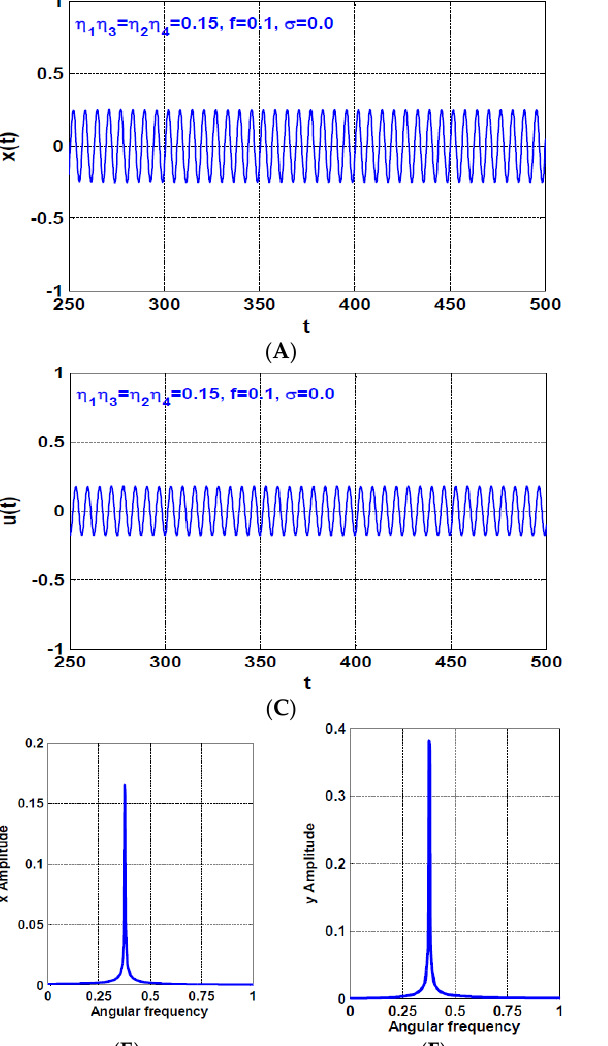
Figure 22. The rotor system steady-state time-response according to the point p 1 shown in Figure 21B (i.e., when 𝜎 = 0.0 , 𝜂 1 𝜂 3 = 𝜂 2 𝜂 4 = 0.1 ): ( A , B ) temporal oscillation in 𝑋 and 𝑌 directions, re- spectively, ( C , D ) temporal oscillations of the U-IRC and V-IRC, respectively, ( E , F ) frequency spec- trum, ( G , H ) the corresponding Poincaré map.